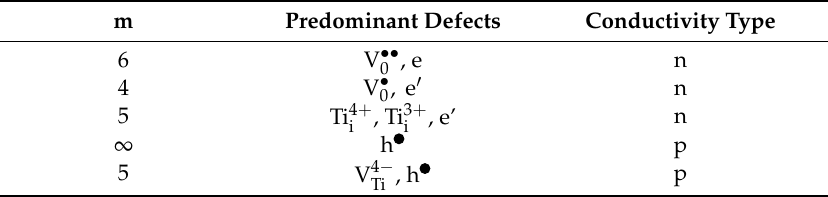
Table 4. Predominant defects and conductivity of Titania depending on the oxygen activity. Reproduced from [131], Copyright 1996, Elsevier.